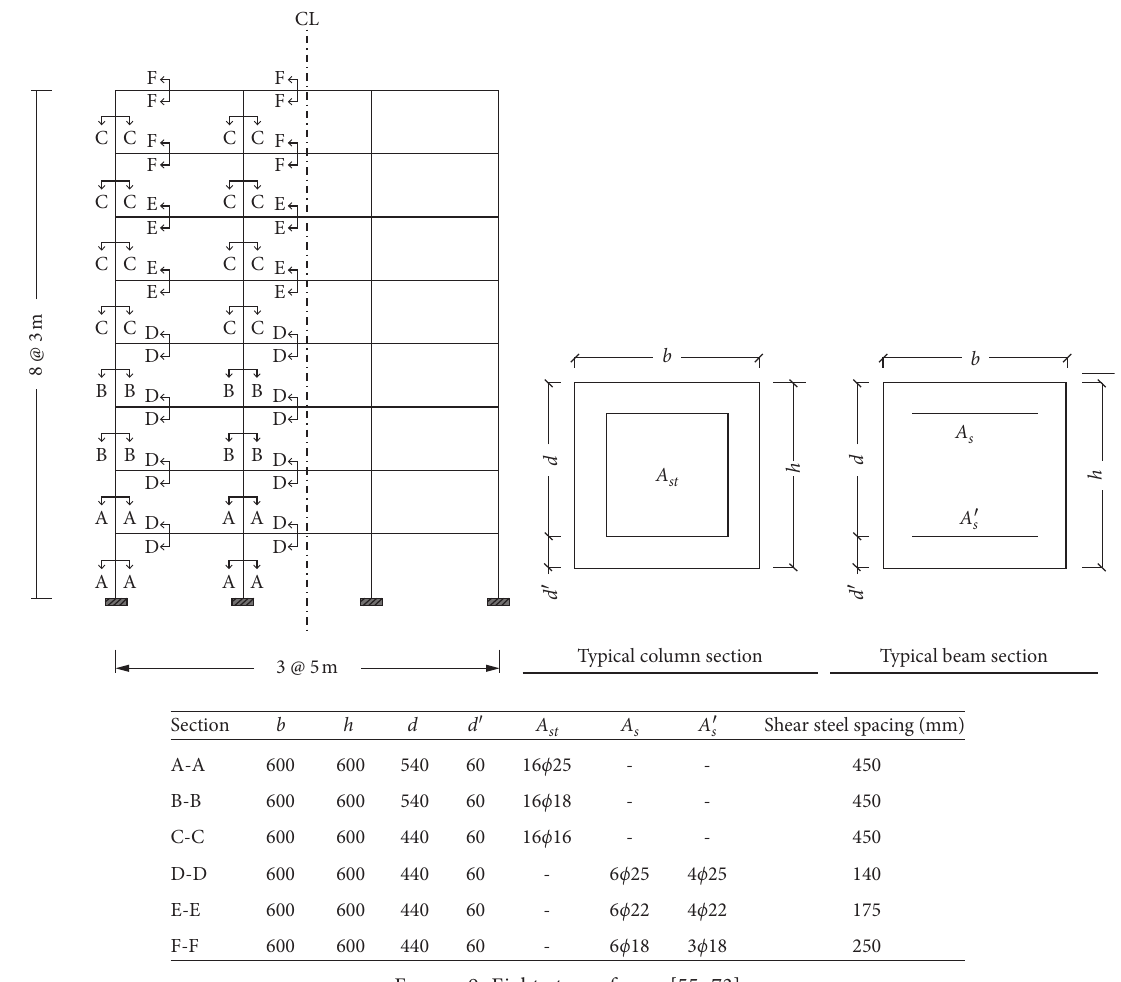
Figure 9: Eight-storey frame [55, 73].